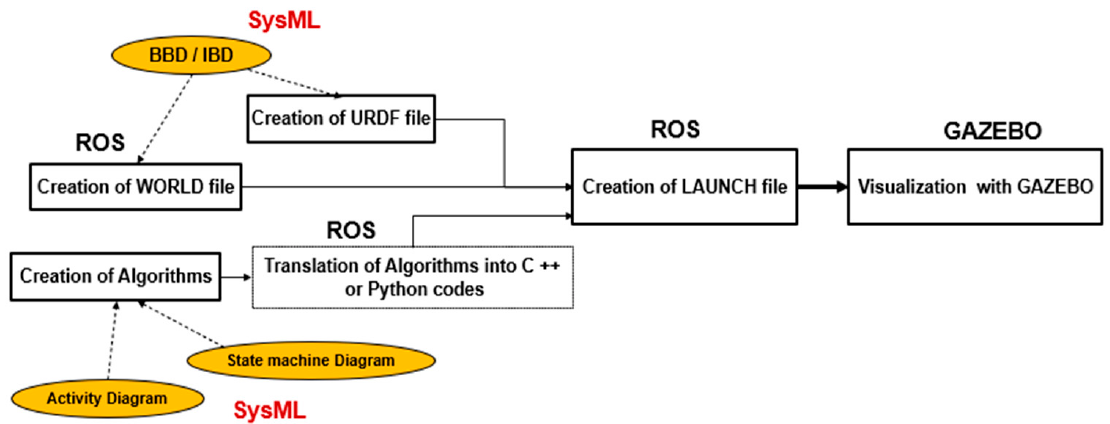
Figure 15. ROS integration methodology.